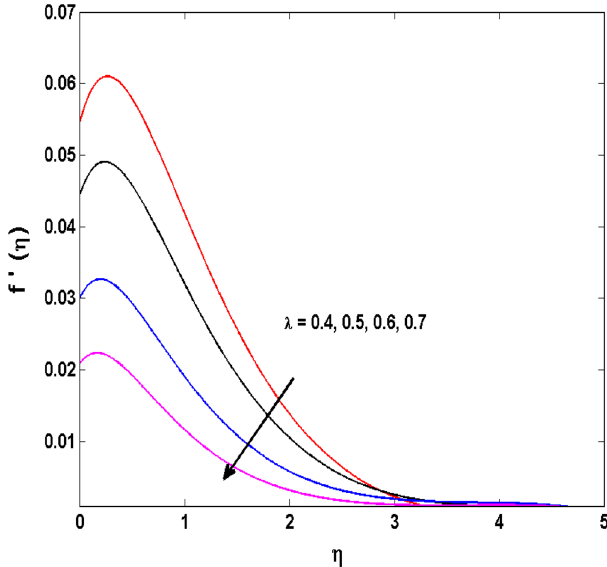
Figure 8. Variations of (cid:31) to f ′ (η) .